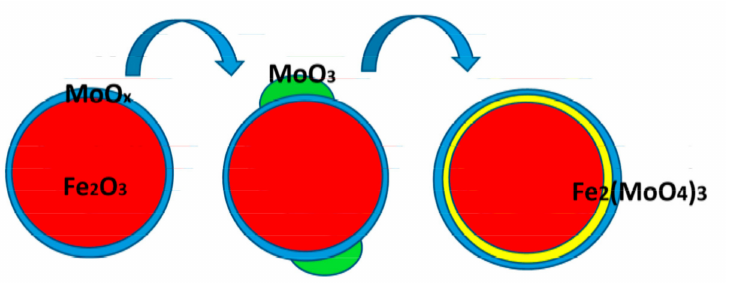
Figure 2. Evolution of the surface structure of 3 ML MoO 3 deposited on Fe 2 O 3 catalyst as function of the annealing temperature. Left: Structure at 120 ◦ C. Middle: Structure at 400 ◦ C. Right: Structure at 500 ◦ C. (red) Fe 2 O 3 ; (blue) amorphous layer of MoO x ; (green) MoO 3 nano-crystallites; (yellow) Fe 2 (MoO 4 ) 3 [28]. Reproduced from [28] Copyright 2016,